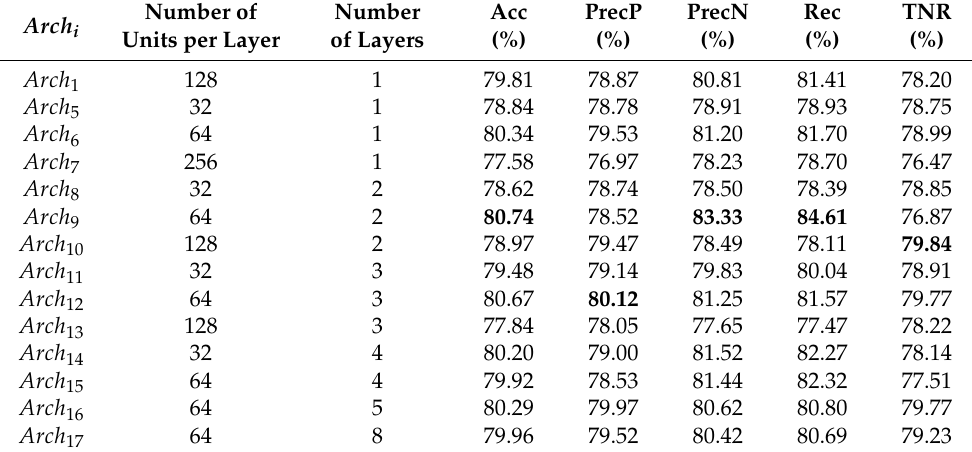
Table 6. Results for varying the number of layers and number of memory cells on the testing